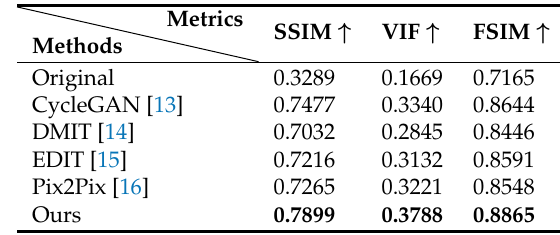
Figure 7. FR-IQA values of the face images synthesized by various algorithms on the MultiPIE dataset. ( a ) SSIM values of generated faces; ( b ) VIF values of synthesized faces; ( c ) FSIM values of synthesized faces. Table 1. Average FR-IQA values of the face images synthesized by various illumination-processing methods on the MultiPIE